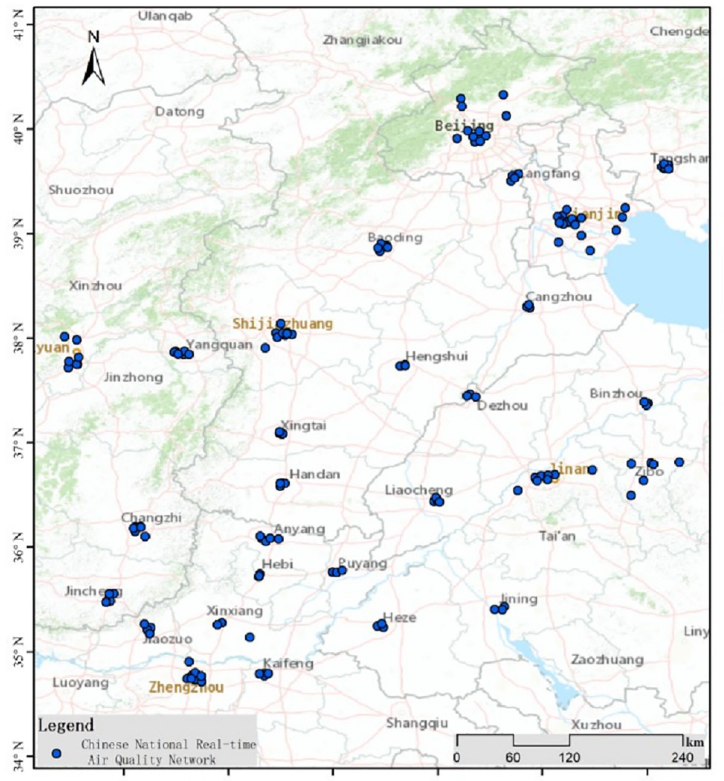
Fig 1. Locations of air quality monitoring sites in the BTH “2+26” cities. The map was prepared in ARCGIS using political boundaries from the Global Database of Administrative Areas (https://resources.arcgis.com/en/help/).